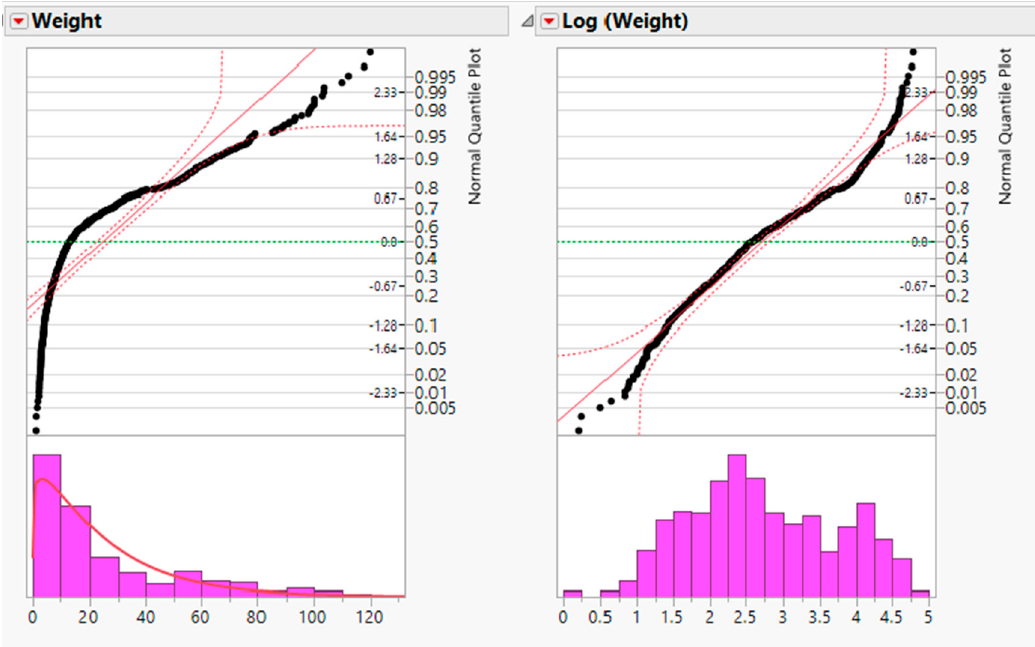
Figure 6. The normal Q–Q plots (up) for the weight variable before and after transformation and the frequency histogram of the weight variable on the left (down) fitted to a gamma distribution (red).